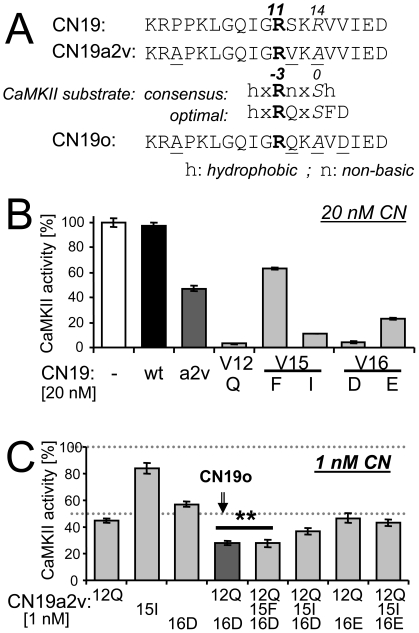
Rational mutagenesis dramatically improved potency in the optimized CN19o.
A, Sequence alignment illustrates the rationale for further mutagenesis. The initial Ala scan (Fig. 2) indicated that R11 of CN19 may constitute the −3 position R of a pseudo-substrate sequence. B, The CN19a2v mutations V12Q, V15I and V16D dramatically increase CaMKII inhibition. C, The optimal combination mutant of CN19a2v was V12Q, V16D (CN19o). Additional V15F mutation did not further increase inhibition of CaMKII (0.5 nM), and all other combination mutants showed less CaMKII inhibition (**, p<0.05). Error bars indicate s.e.m. in all panels.